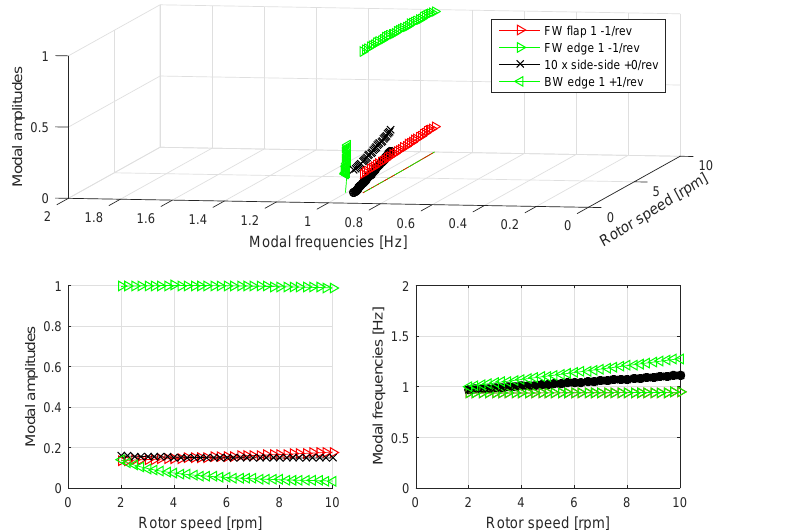
Figure 11. Harmonic modal components for the three-bladed turbine mode dominated by forward whirling (FW) of the rotor in the edgewise DOF. Plot layout as in Fig. 5.